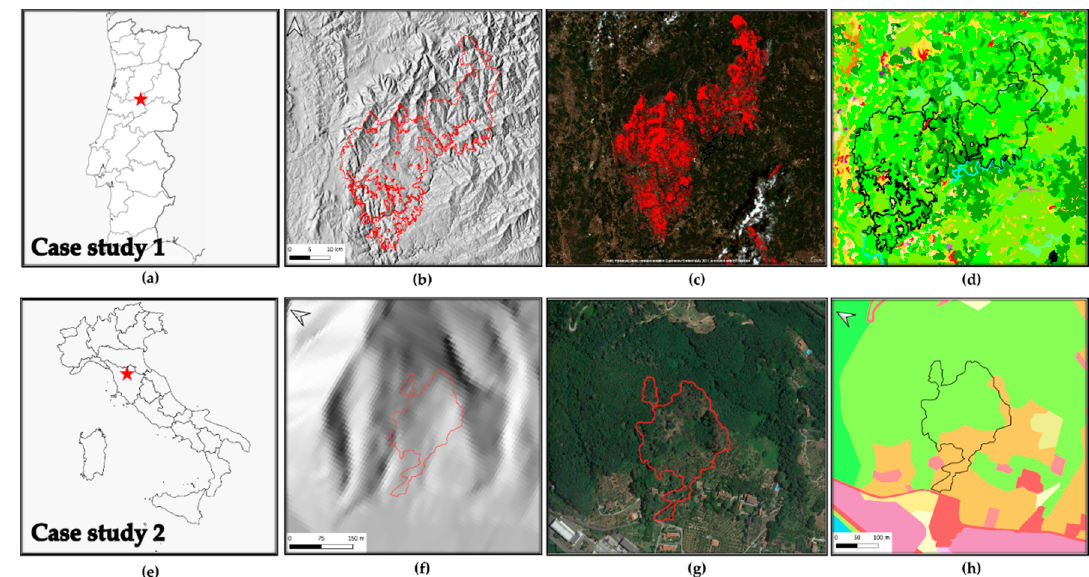
Figure 2. Case study 1: ( a ) location of the study site in Portugal; ( b ) digital elevation model of the study area 25 × 25 m [73], ( c ) Copernicus sentinel hub burned area [74], ( d ) 2012 Corine land cover [75], legend accessible at [76]. Case study 2: ( e ) location of the study site in Italy; ( f ) digital elevation model, ( g ) Google earth view of wildfire burned area, ( h ) Tuscan database for landcover, legend accessible at [77].